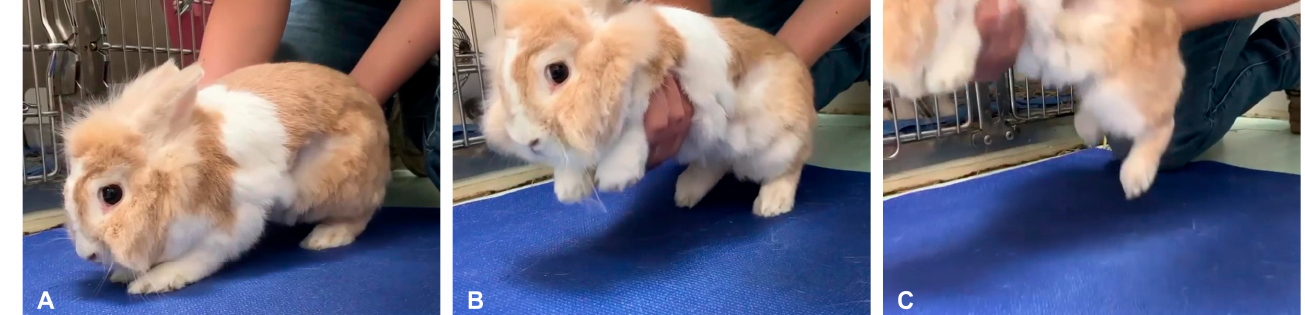
Figure 1. Three different methods to test the hopping reaction in the left pelvic limb. ( A ) Holding the animal with its 3 feet on the surface. ( B ) Holding the animal with only the tested limb touching the surface. ( C ) Holding then lowering the animal quickly towards the floor with only the tested limb touching the ground.